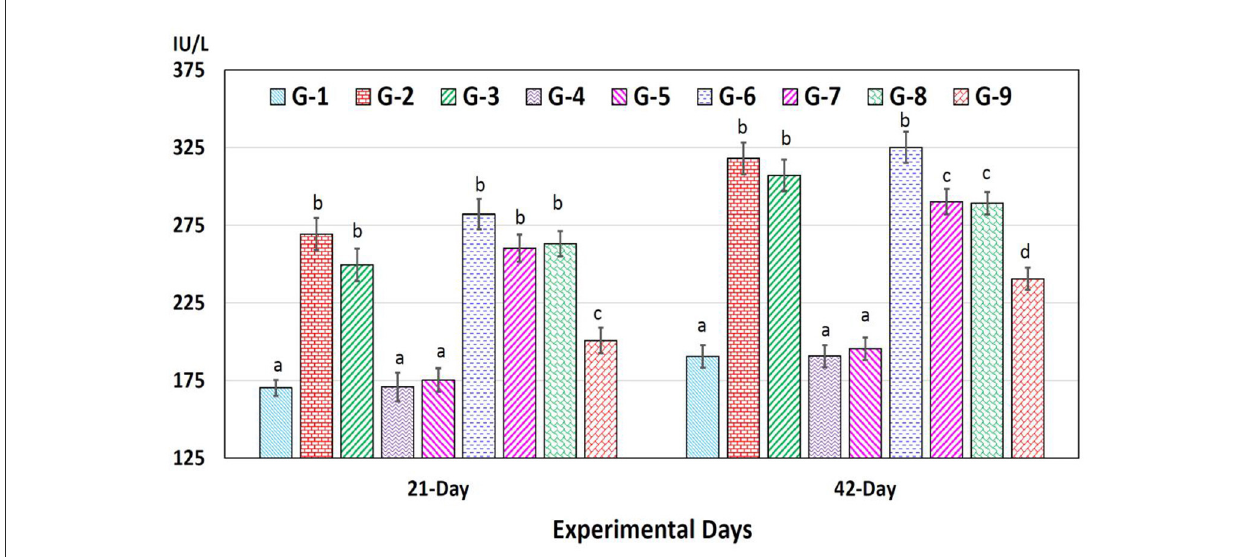
FIGURE3 Aspartate aminotransferase (AST) in broiler chicks on 21 and 42 experiment days administered arsenic, chromium, vitamin E, and bentonite alone or in combinations. Bars (mean ± SE) having dissimilar letters under a specific experimental day vary significantly ( p < 0.05). Chromium, arsenic, and vitamin E were given @ 270, 50, and 150mg.kg − 1 , respectively, while bentonite was administered @ 5%. G1 = Group 1: Control (negative); G2 = Group 2: Chromium; G3 = Group 3: Arsenic; G4 = Group 4: Vitamin E; G5 = Group 5: Bentonite; G6 = Group 6: Chromium + Arsenic; G7 = Group 7: Chromium + Arsenic + Vitamin E; G8 = Group 8: Chromium + Arsenic + Bentonite; and G9 = Group 9: Chromium + Arsenic + Vitamin E + Bentonite.